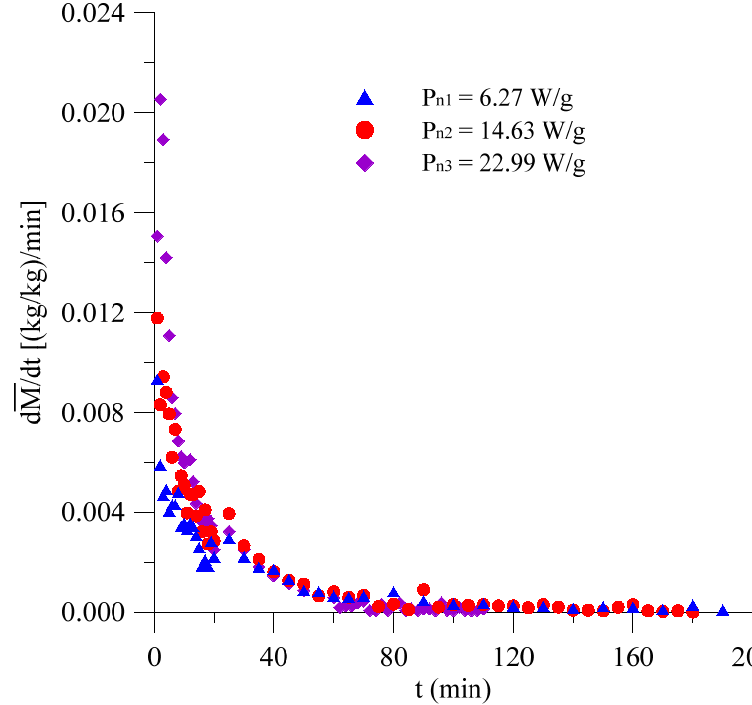
Figure 4. Drying rate of rice grains for different microwave powers.